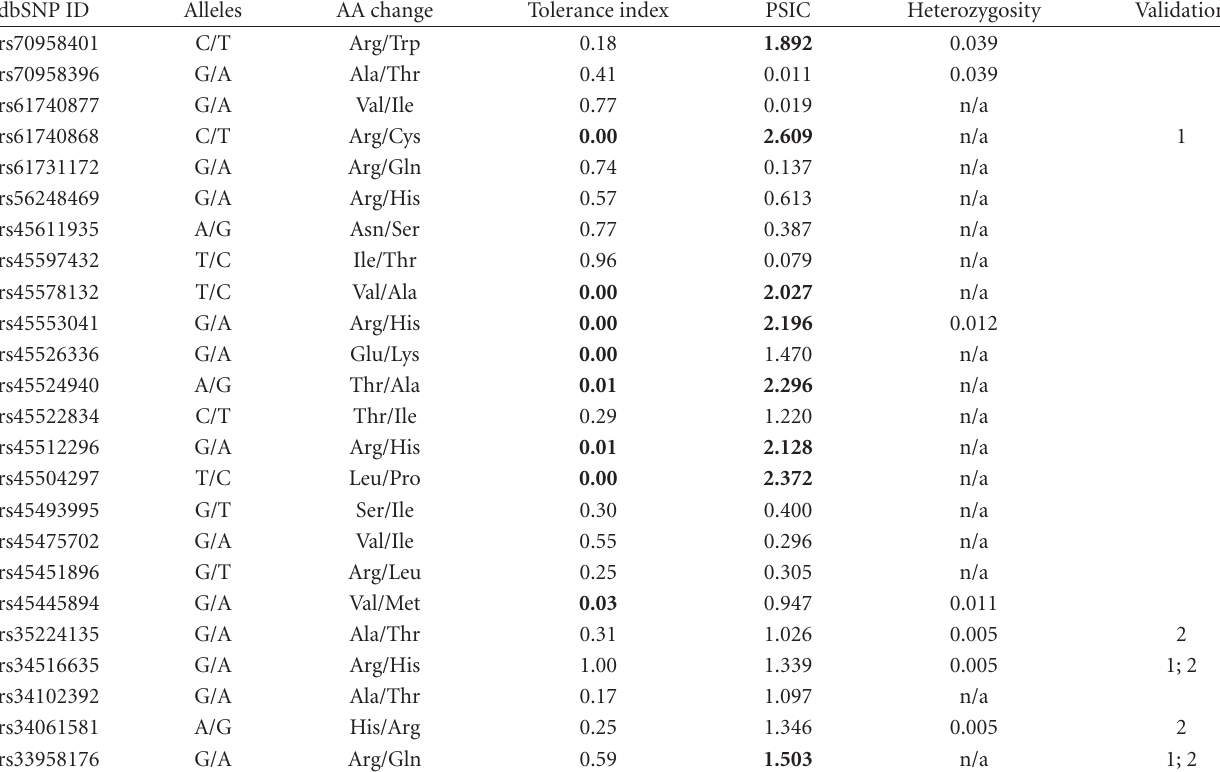
Table 1: List of nsSNPs that were analysed by SIFT and